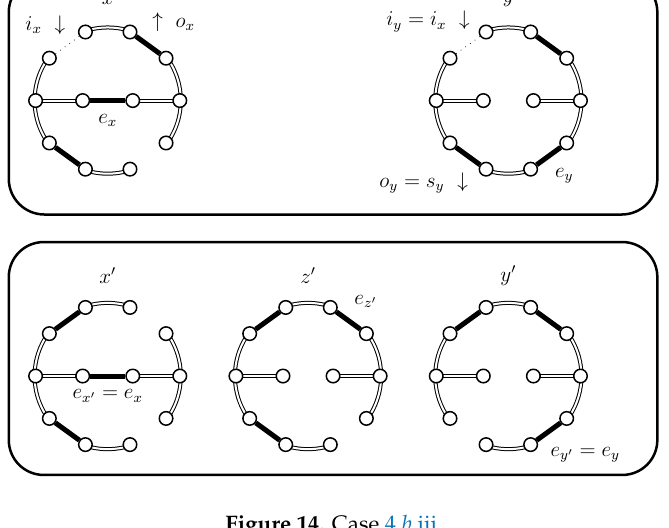
Figure 14: Case 4. b .iii. Figure 14. Case 4. b .iii.